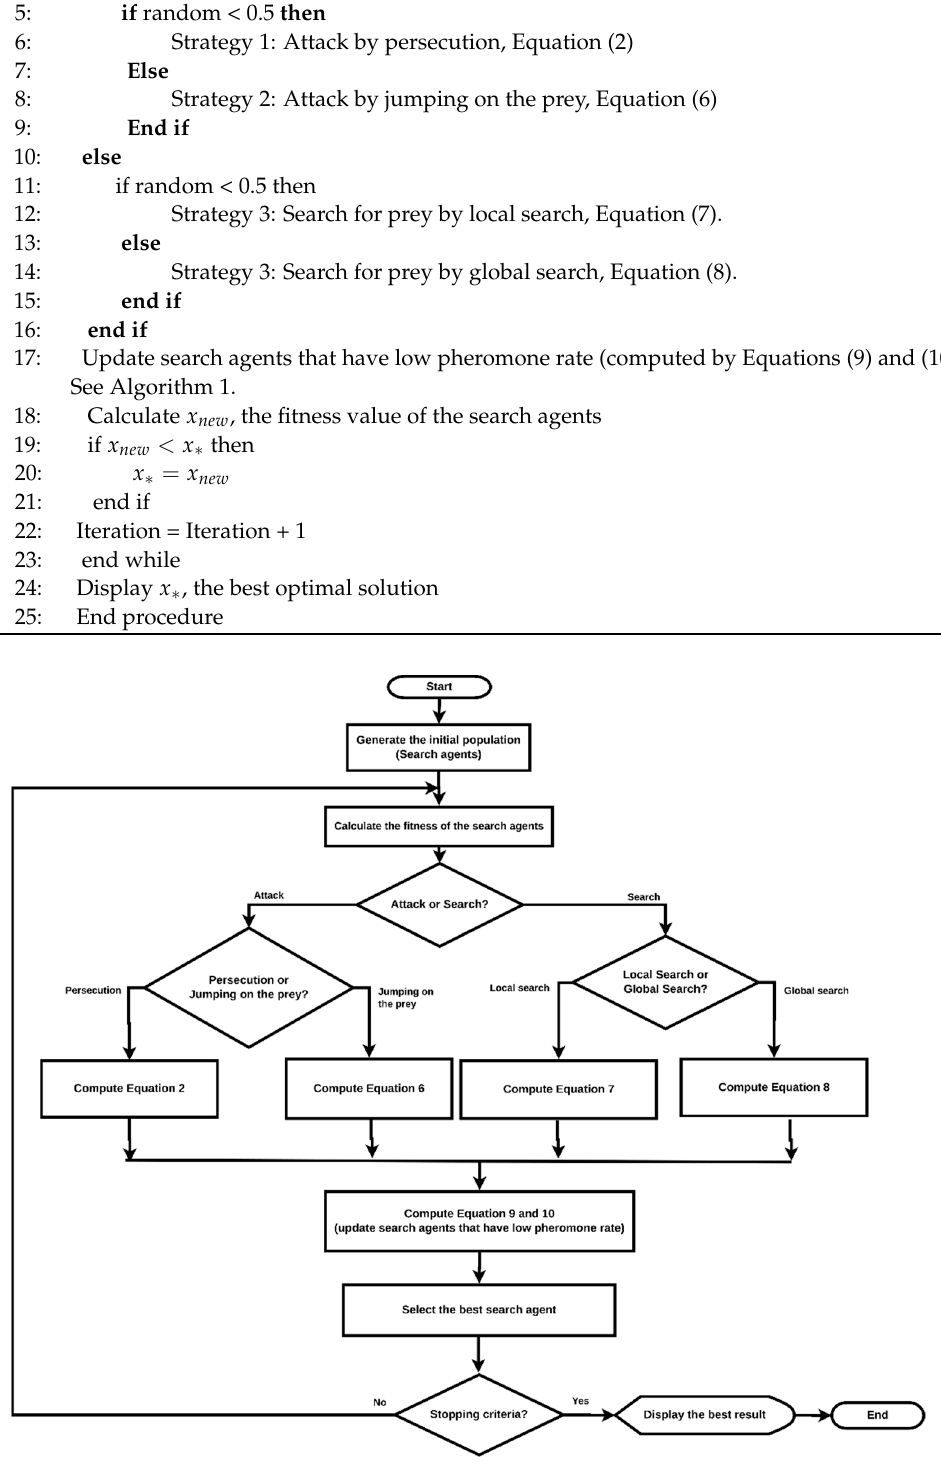
Figure 6. JSOA flowchart.